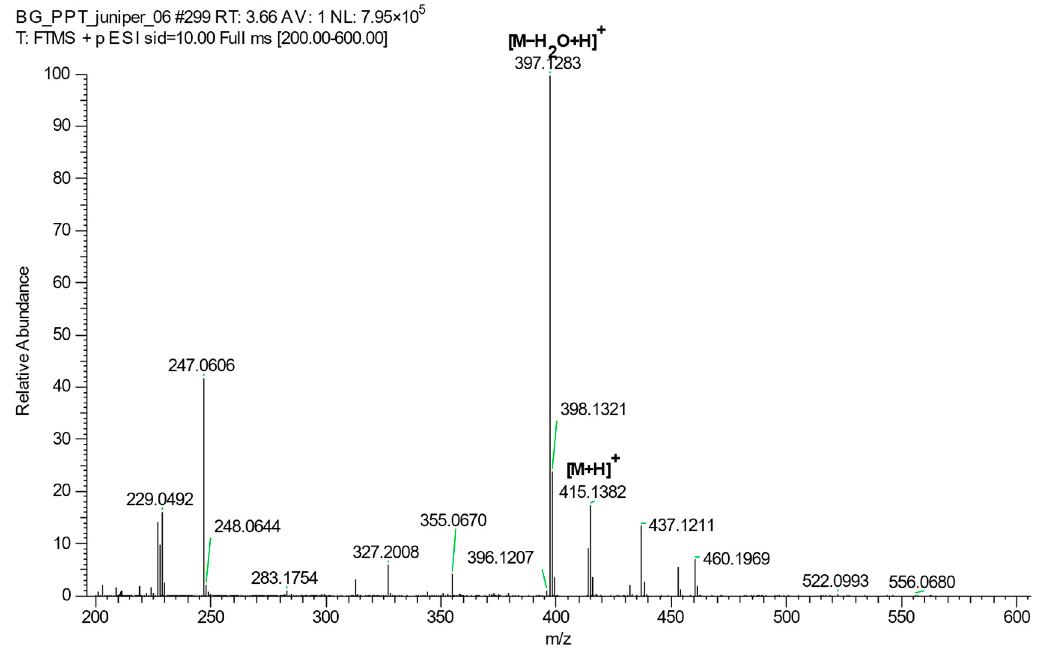
Figure 7. The full MS-SIM spectrum of podophyllotoxin.